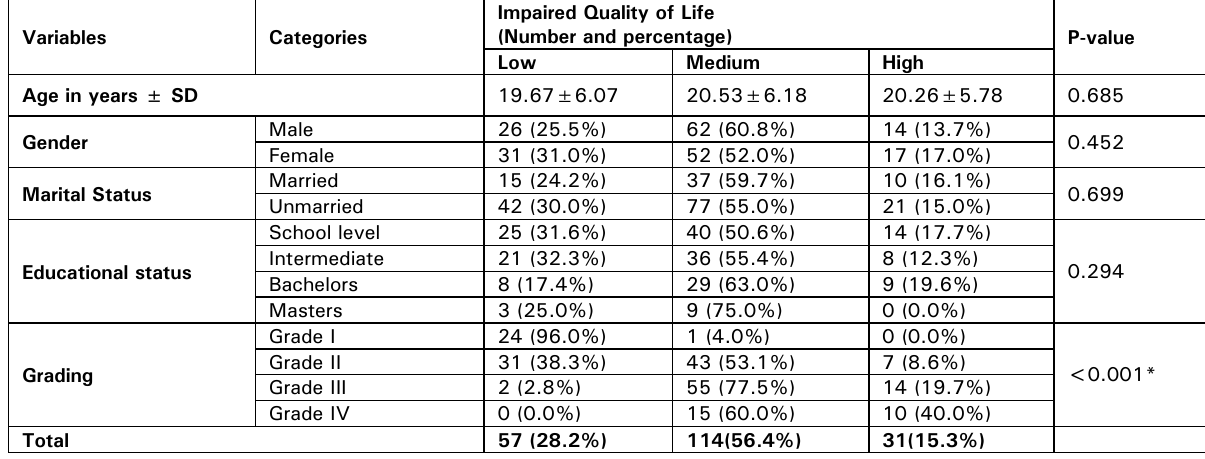
Table 2: Analysis of Impact on quality of life according to CADI